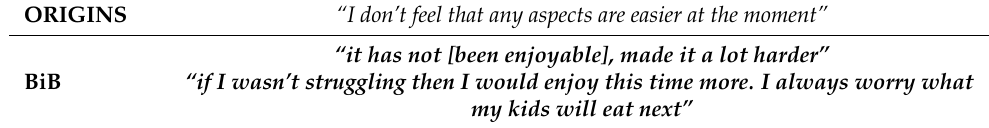
Table 9. Negative impacts: Sample